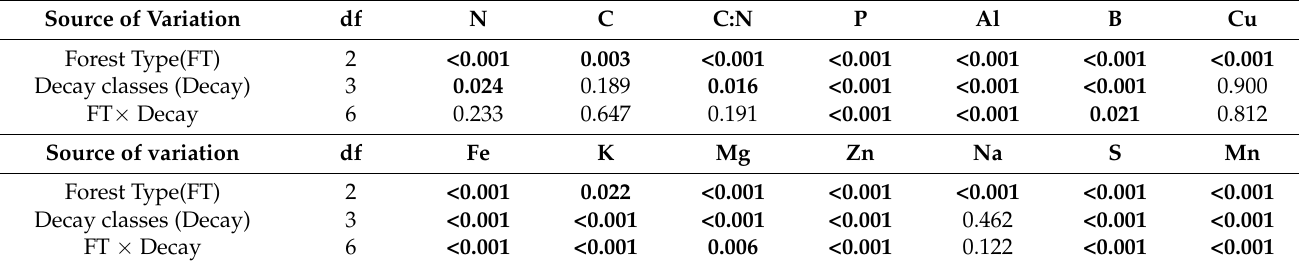
Table 3. ANOVA results for forest types, decay classes, and their interactions on nutritional compositions of different forest types of Picea koraiensis-Abies nephrolepis-Pinus koraiensis forest (PAPF), Betula costata-Pinus koraiensis forest (BPF), and Tilia amurensis-Pinus koraiensis forest (TPF) in Northeastern China. Abbreviations: N: nitrogen; C: carbon; C:N: carbon to